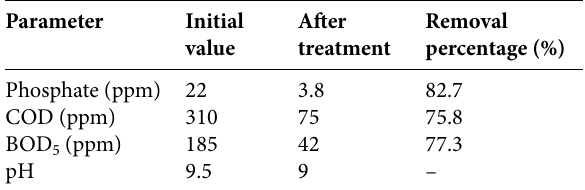
Table 6. The concentration of contaminants in urban wastewater before and after adding MnFe 2 O 4 nanoparticles Parameter Initial After Removal value treatment percentage (%) Phosphate (ppm)